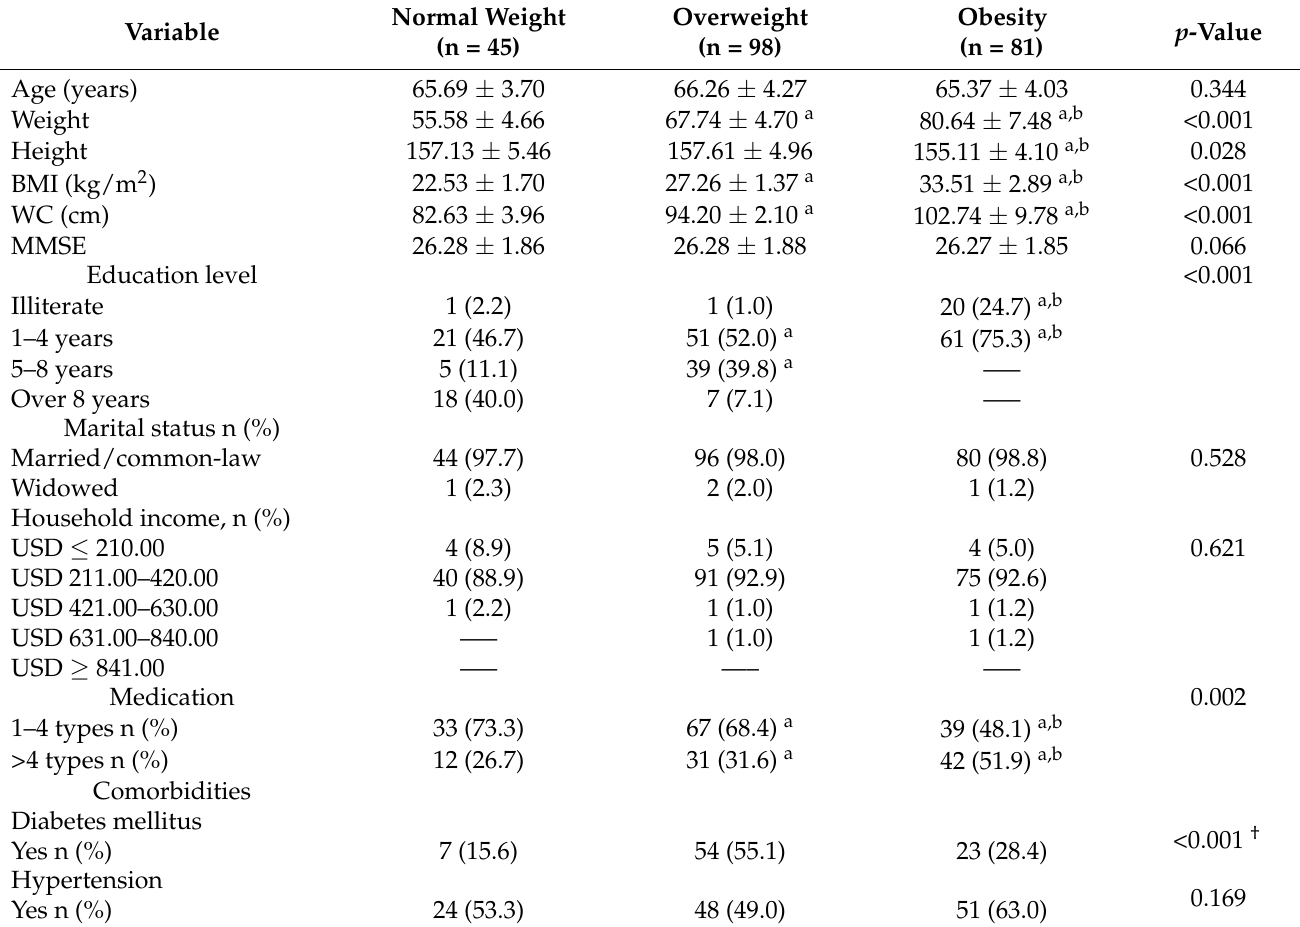
Table 1. Main characteristics of the sample.